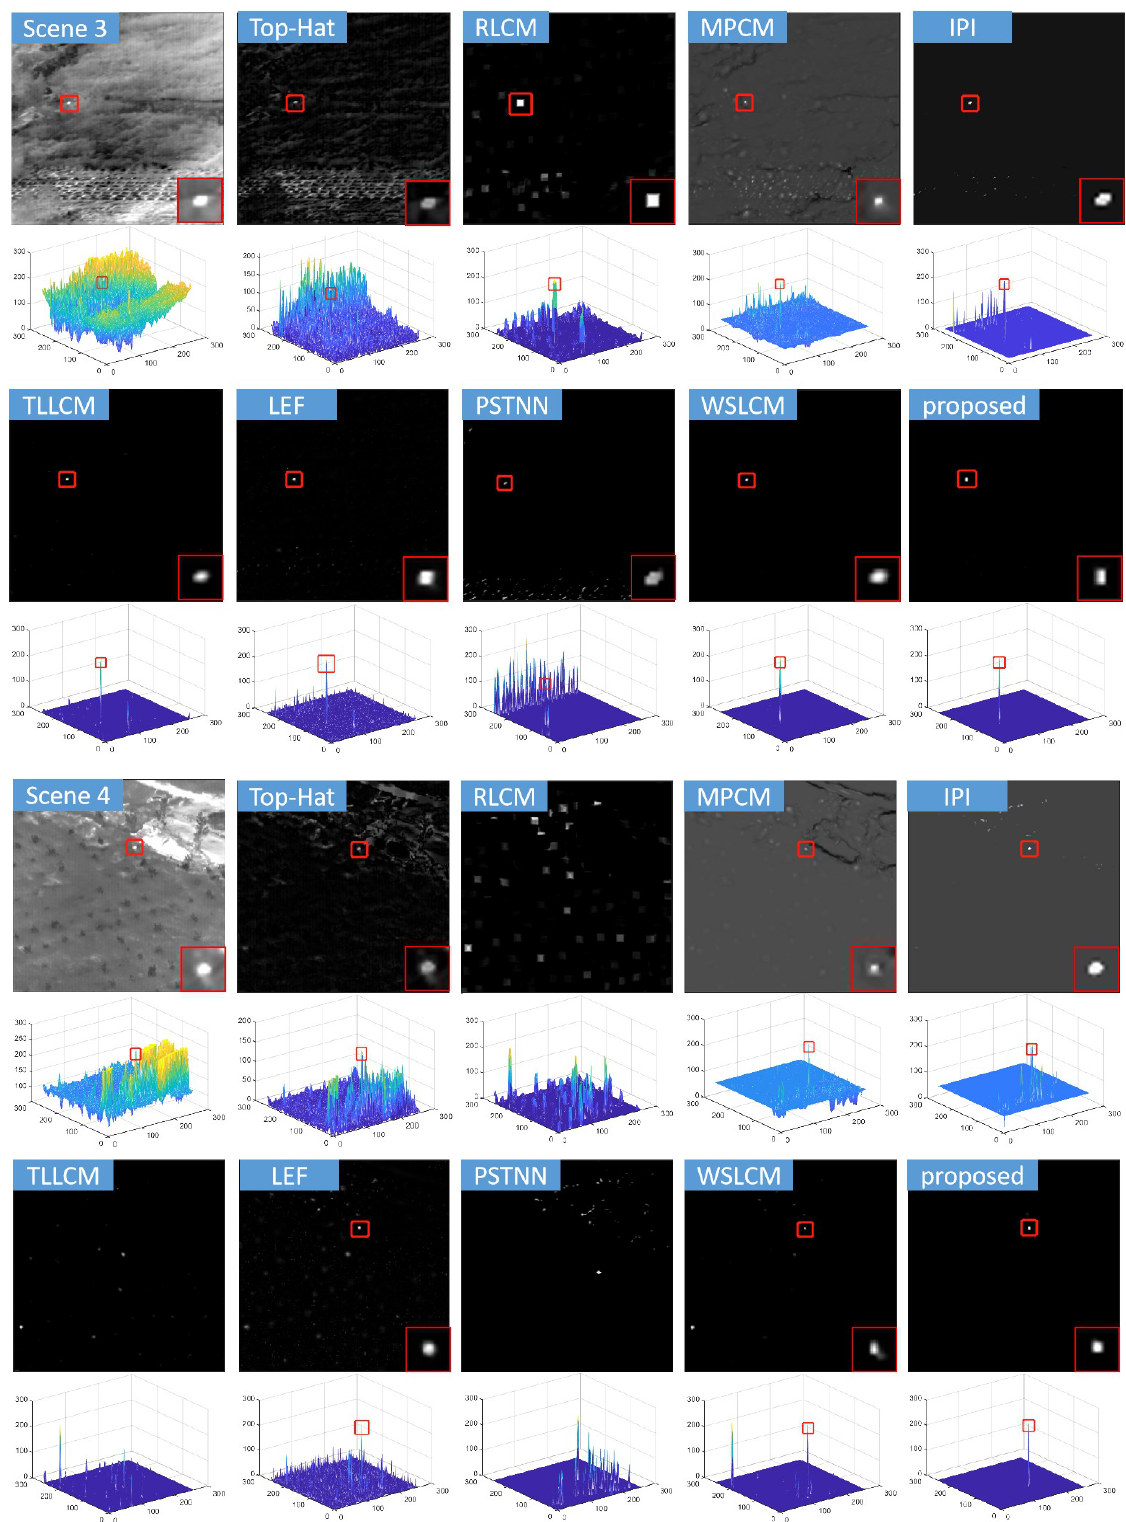
Figure 6. Detection results and 3D distribution of different methods in Scenes 3 and 4. The target is marked with a red box, and a close-up of the target is shown in the lower right corner. Unmarked areas indicate the absence of detection of the